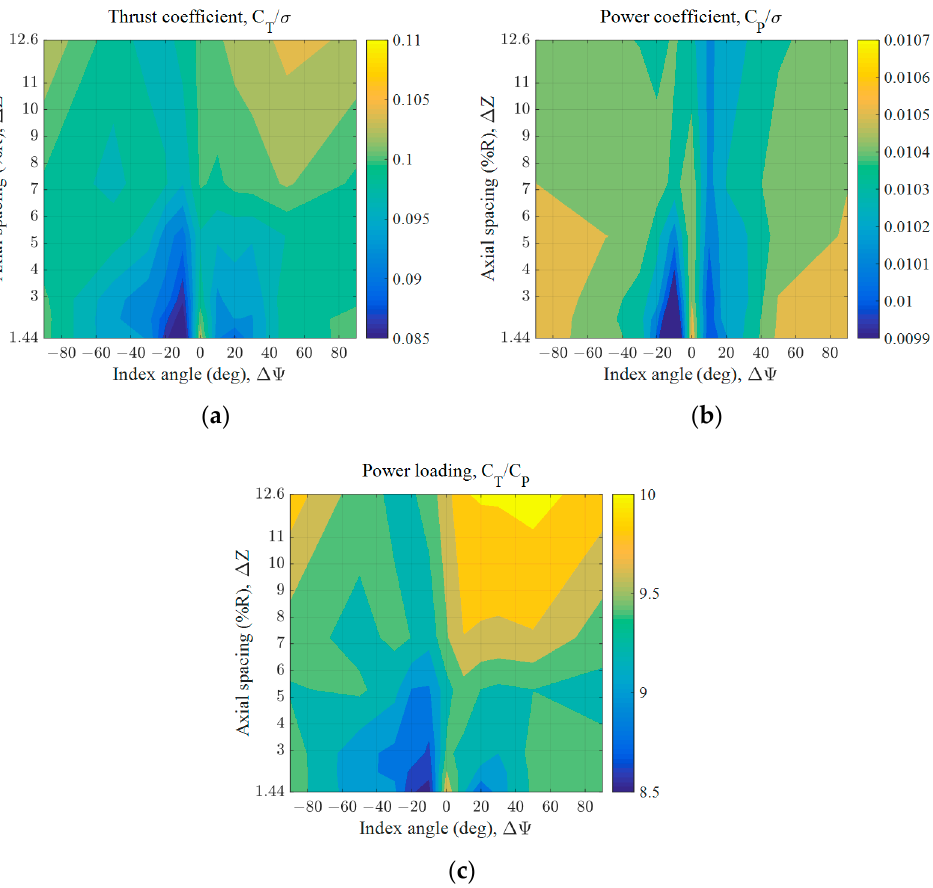
Figure 10. Hover performance analyses with respect to various index angles and axial spacings (collective pitch angle = 12 ◦ ): ( a ) Thrust ( C T / σ ); ( b ) power ( C P / σ ); ( c ) power loading ( C T / C P